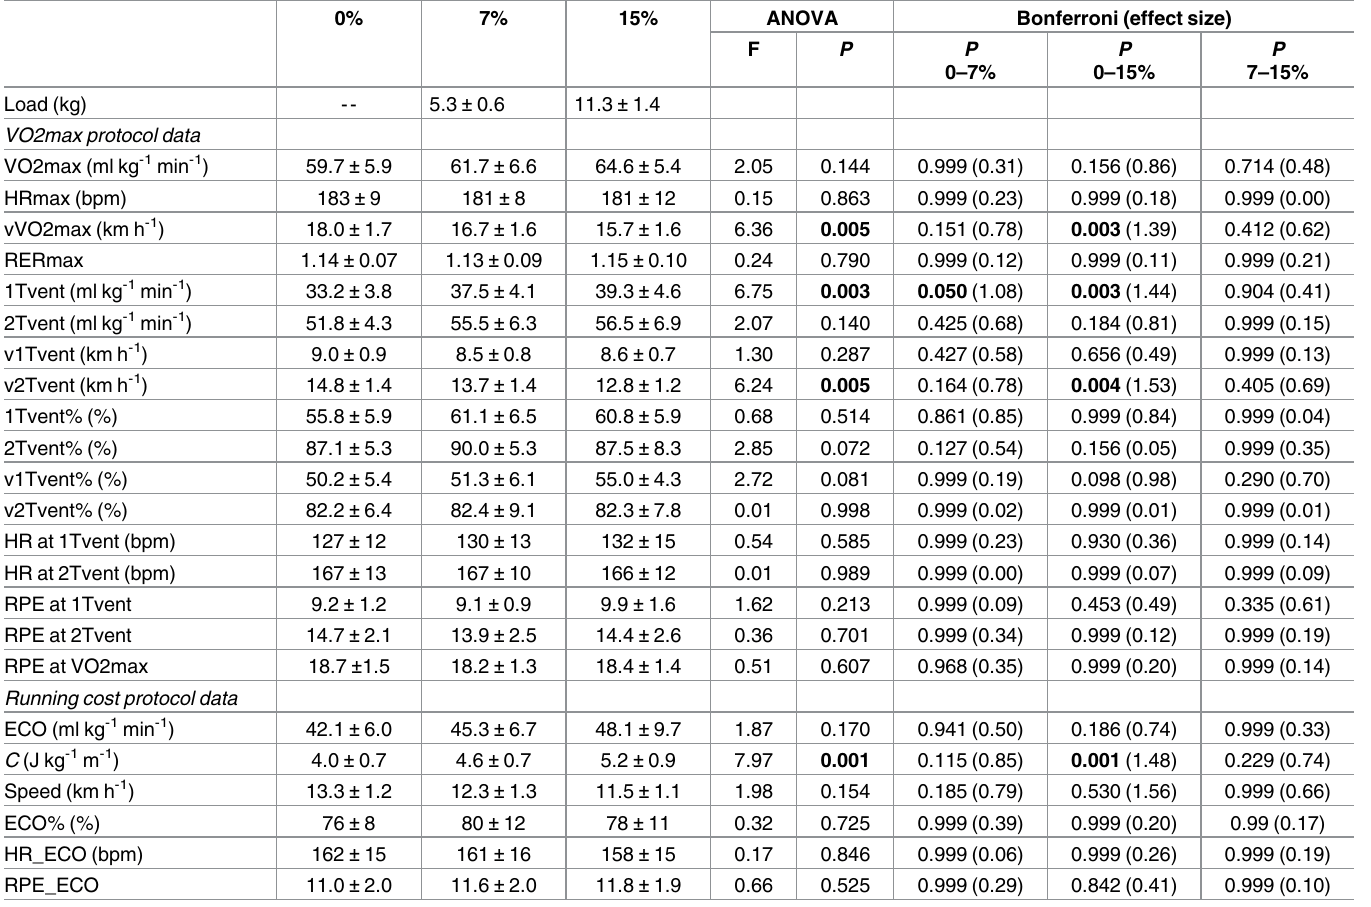
Table 1. Mean, standard deviation, ANOVA, post hoc (Bonferroni) and Cohen’s d effect size results from maximal (VO2max protocol) and submax- imal (running cost protocol) tests. Numbers in bold represent P <